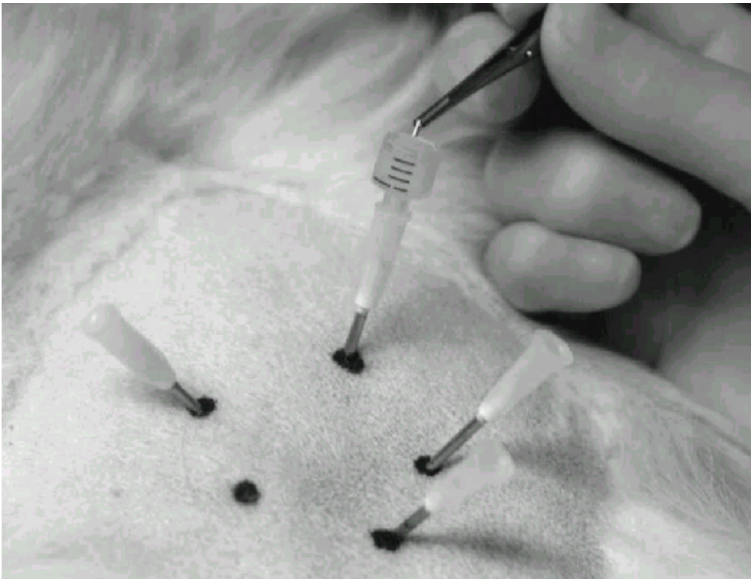
Figure 4. One gold bead is dropped into a needle using forceps and a